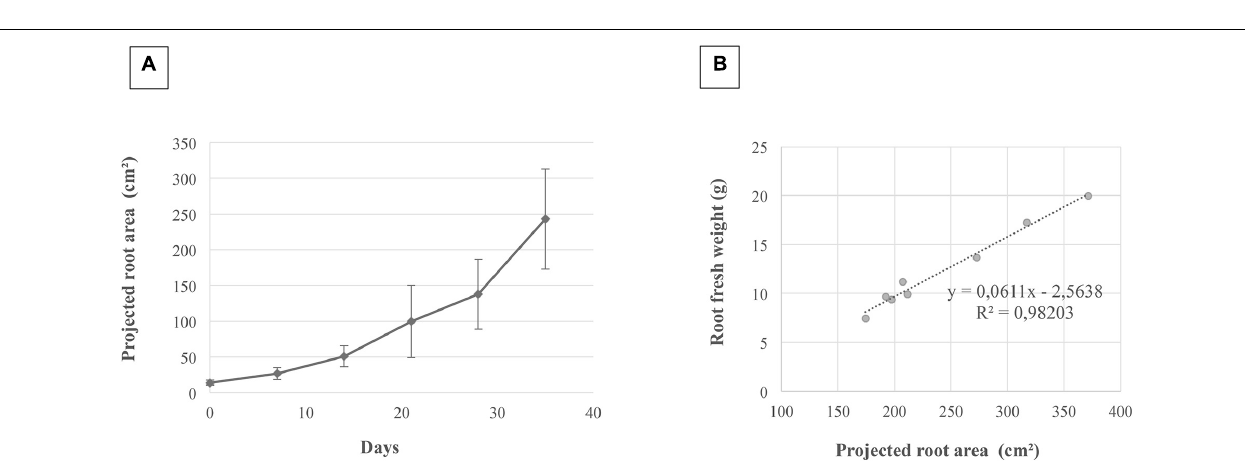
FIGURE 5 | Correlation between the projected root area and root fresh weight. This correlation was determined for grapevine cuttings grown for 5 weeks in rhizotrons. Illustration of the projected root area calculated from root image analysis on 72 images (A) . Four images were analyzed for each time point, and three biological repetitions were carried out. Bars correspond to standard errors. Correlation between the projected root area and the root fresh weight (B) .